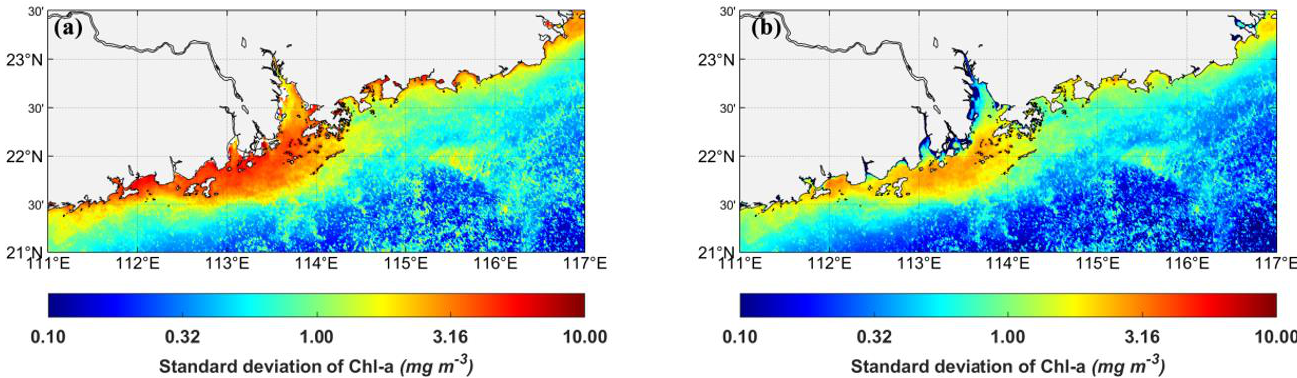
Figure 8. Standard deviation of chlorophyll-a concentration computed from the complete dataset: ( a ) satellite-derived; ( b ) network reconstructed. The daily-averaged C chla in the coastal and estuarine area are shown in Figure 9.